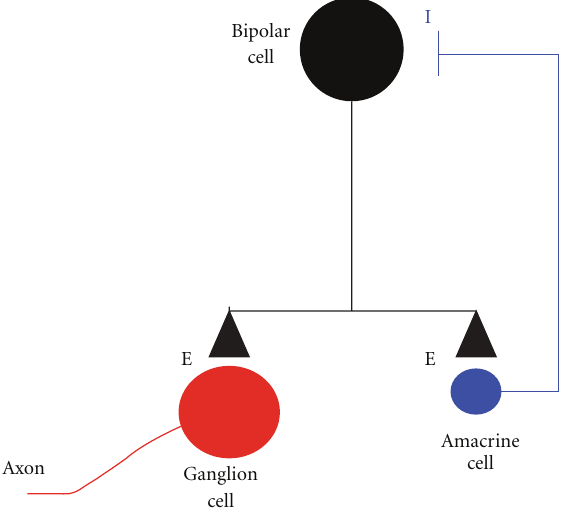
Figure 2: Retinal circuit that may give rise to spontaneous ganglion cell spike activity. The membrane potential of the amacrine cell oscillates spontaneously due to resonance (see text) which drives oscillatory release of inhibitory transmitter on to the bipolar cell causing oscillations in bipolar voltage triggering pulsatile release of excitatory transmitter on to the ganglion cell, causing rhythmic spike discharge, and the amacrine cell with negative feedback to the bipolar. The reverberating input to the ganglion cell arises from the presence of a negative feedback loop that includes a resonant